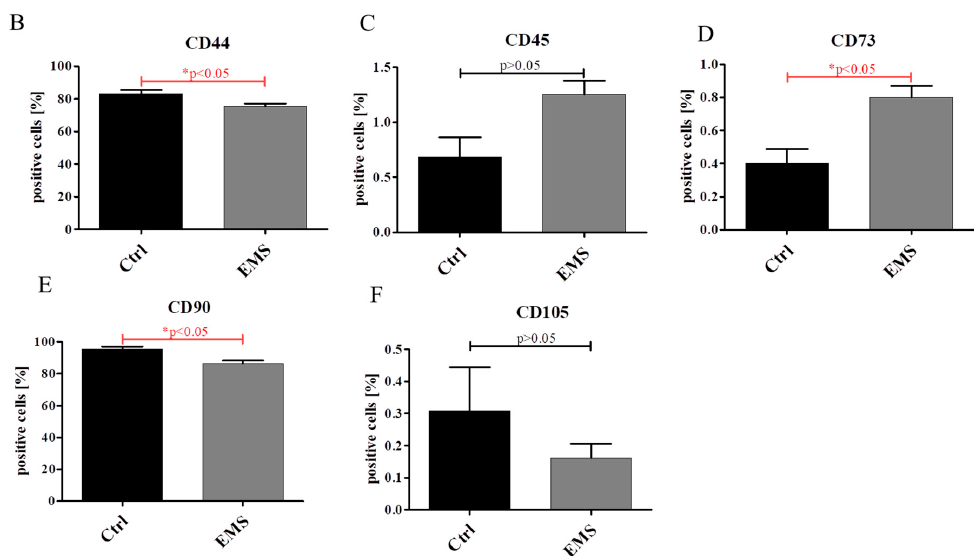
Figure 1. Flow cytometry analysis of IECs phenotype ( A ). Isolated cells are characterized by the presence of CD44 ( B ) and CD90 ( E ) markers. The low expression was noted for CD45 ( C ), CD73b ( D ) and 105 ( F ). Comparative analysis revealed a statistically significant difference in the expression of CD44, CD73 and CD90. The increased percentage of CD44 and CD90 cells was noted in an IEC population isolated from control/healthy horses. The IECs EMS were characterized by the highest number of CD73 positive cells. Results are expressed as mean ± S.D. * p < 0.05.